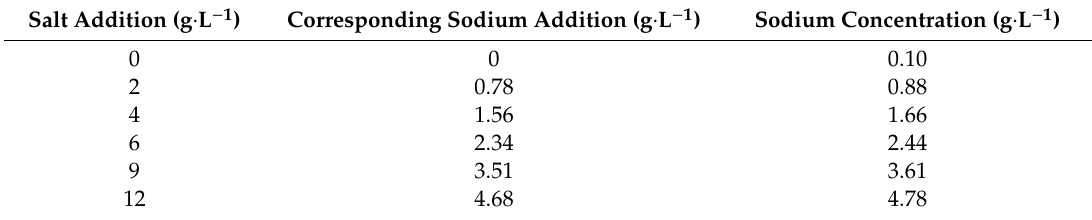
Table A3. Calculation of sodium concentration with di ff erent salt